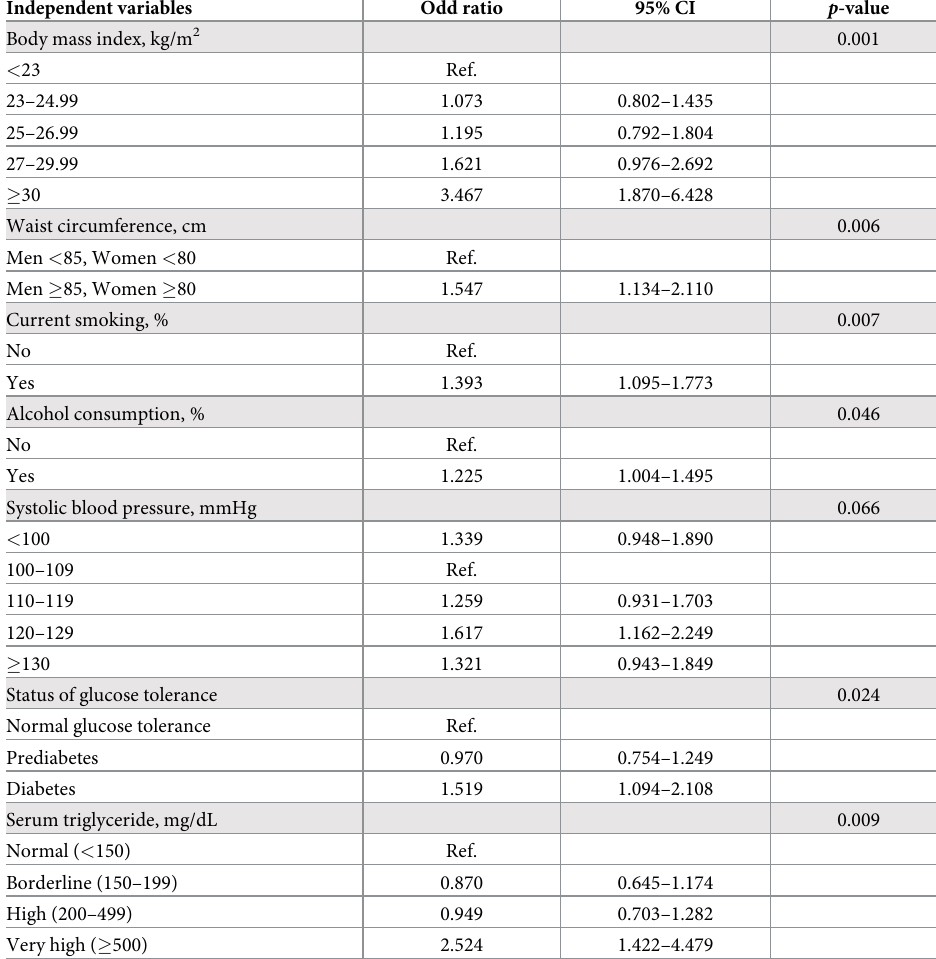
Table 2. Results of multiple logistic regression analysis with hyperfiltration as the dependent variable adjusted with clinical and metabolic parameters � . Independent